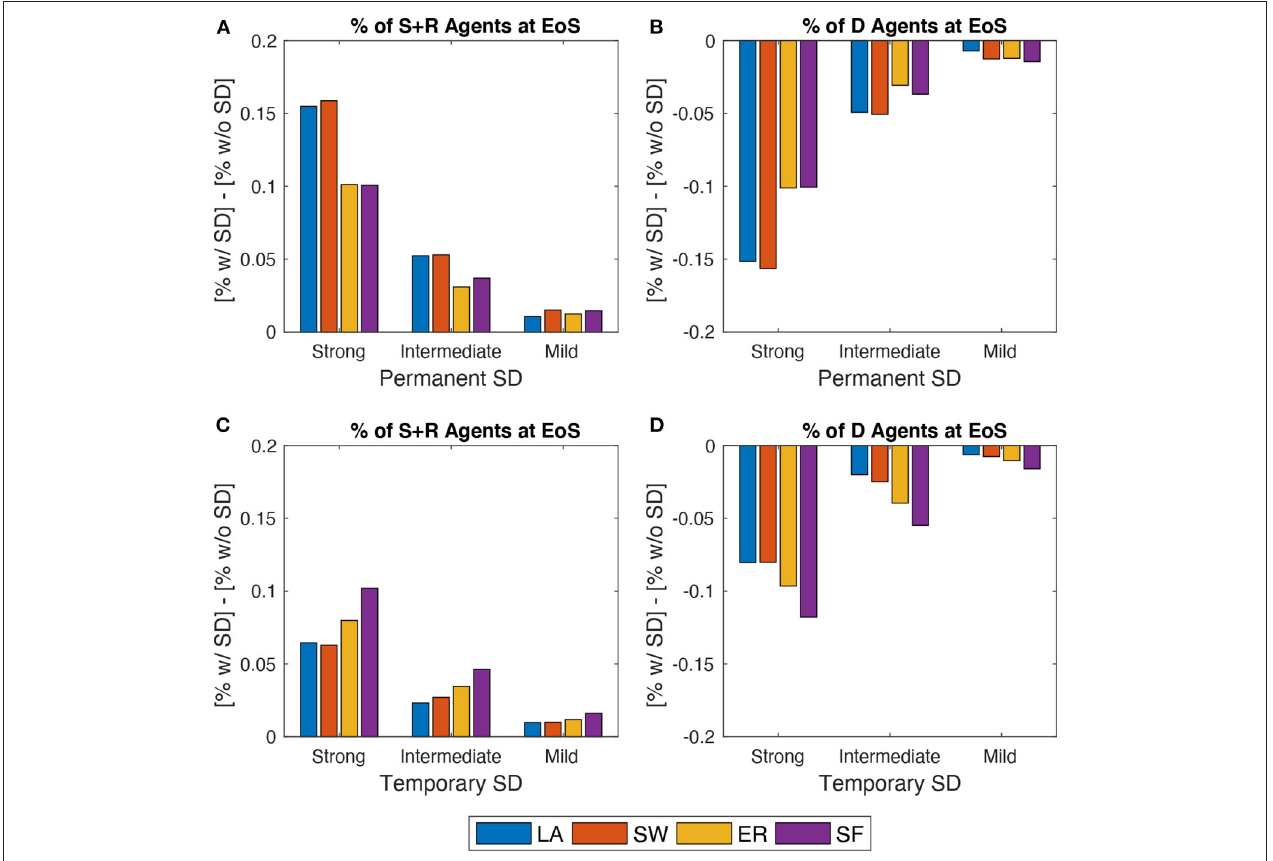
FIGURE 5 | Effects of spatial distancing (SD). Comparing the behavior of the model across three SD setups: Strong vs. Intermediate vs. Bad (see Section 3.4). (A), (B) Permanent SD policy. (C), (D) Temporary SD policy. (A), (C) Share of agents in states S or R at EoS with SD minus the same share without SD. (B), (D) Share of agents in state D at EoS with SD minus same share without SD. Initial average degree: ¯ k = 8. Mid epidemic scenario. Averages across M = 1,000 Monte Carlo